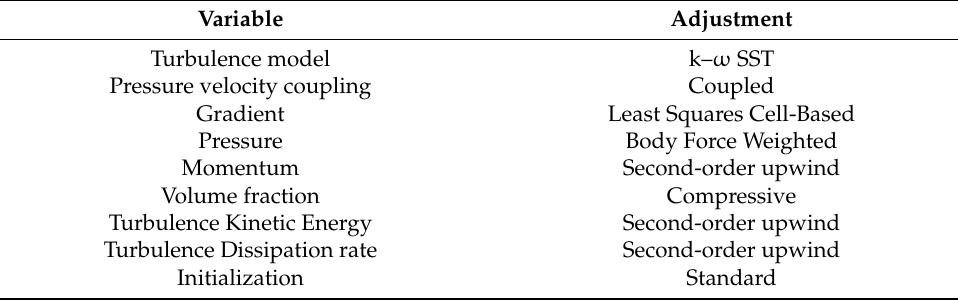
Table 4. Numerical Schemes and Solution Methods